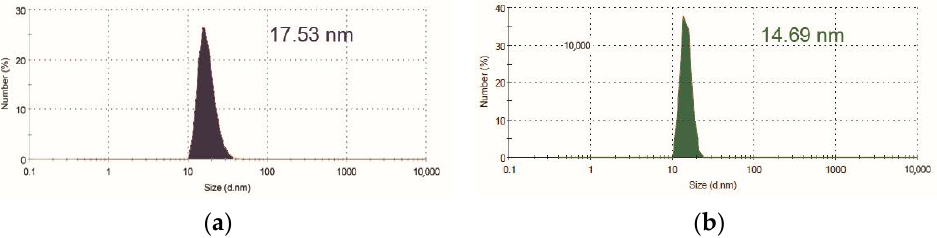
Figure 4. Particle sizes obtained by the dynamic light scattering (DLS) method for micellar solutions of compound 3a ( a ) and 3b ( b ) (concentration 3·10 −6 M).